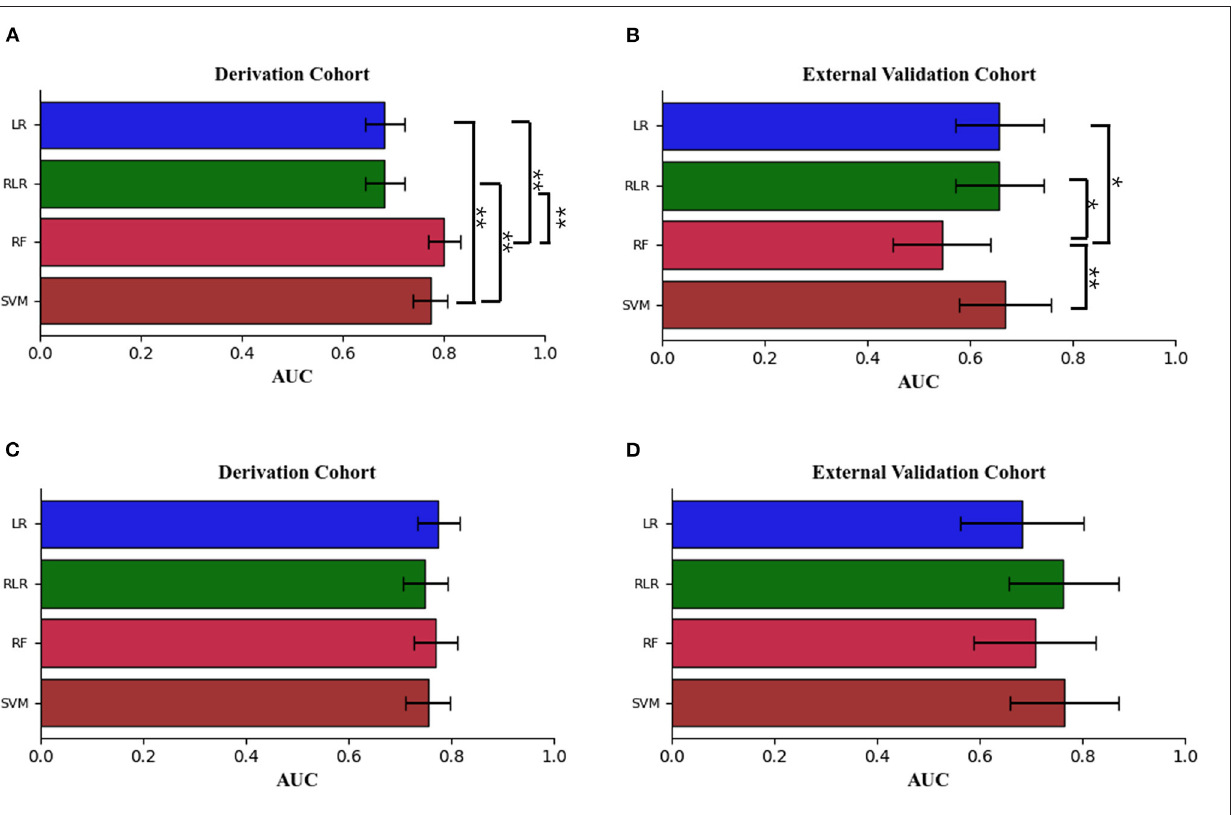
Frontiers in Neurology |